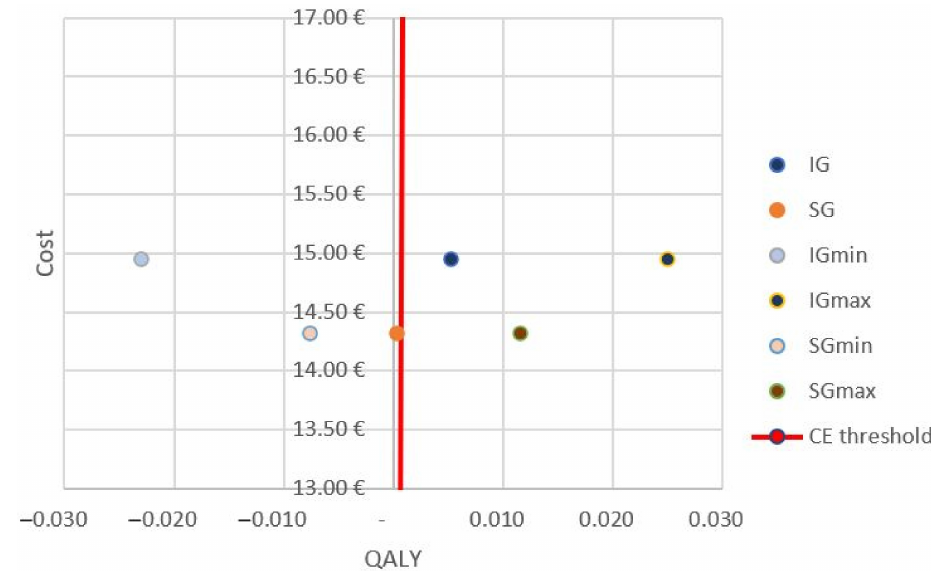
Figure 2. Cost-effectiveness plane. The average, minimum, and maximum values of the IG and SG are shown on the right-hand side of the cost-effectiveness threshold of EUR 20,000/QALY. Abbreviations—IG: intervention group; SG: sham